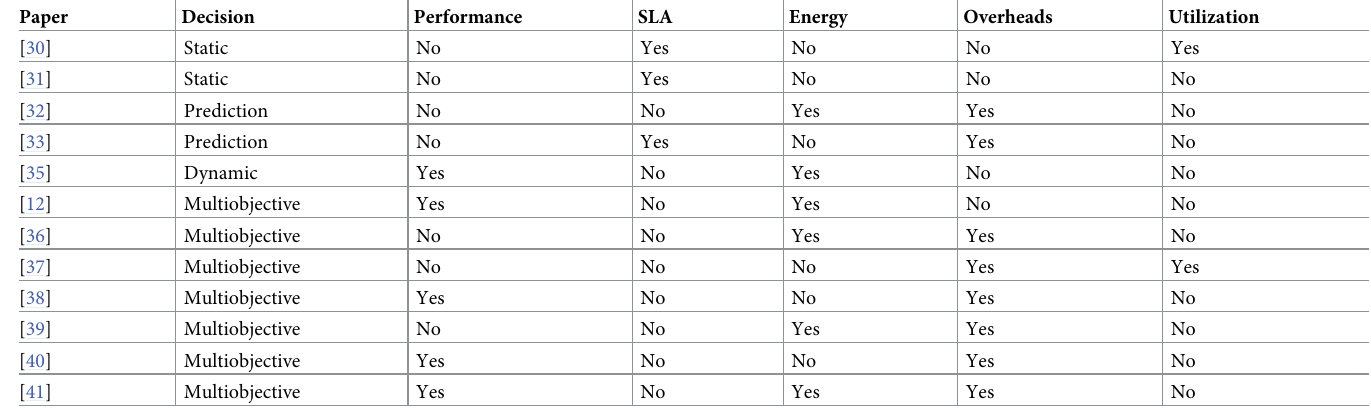
Table 1. Comparison of the consolidation